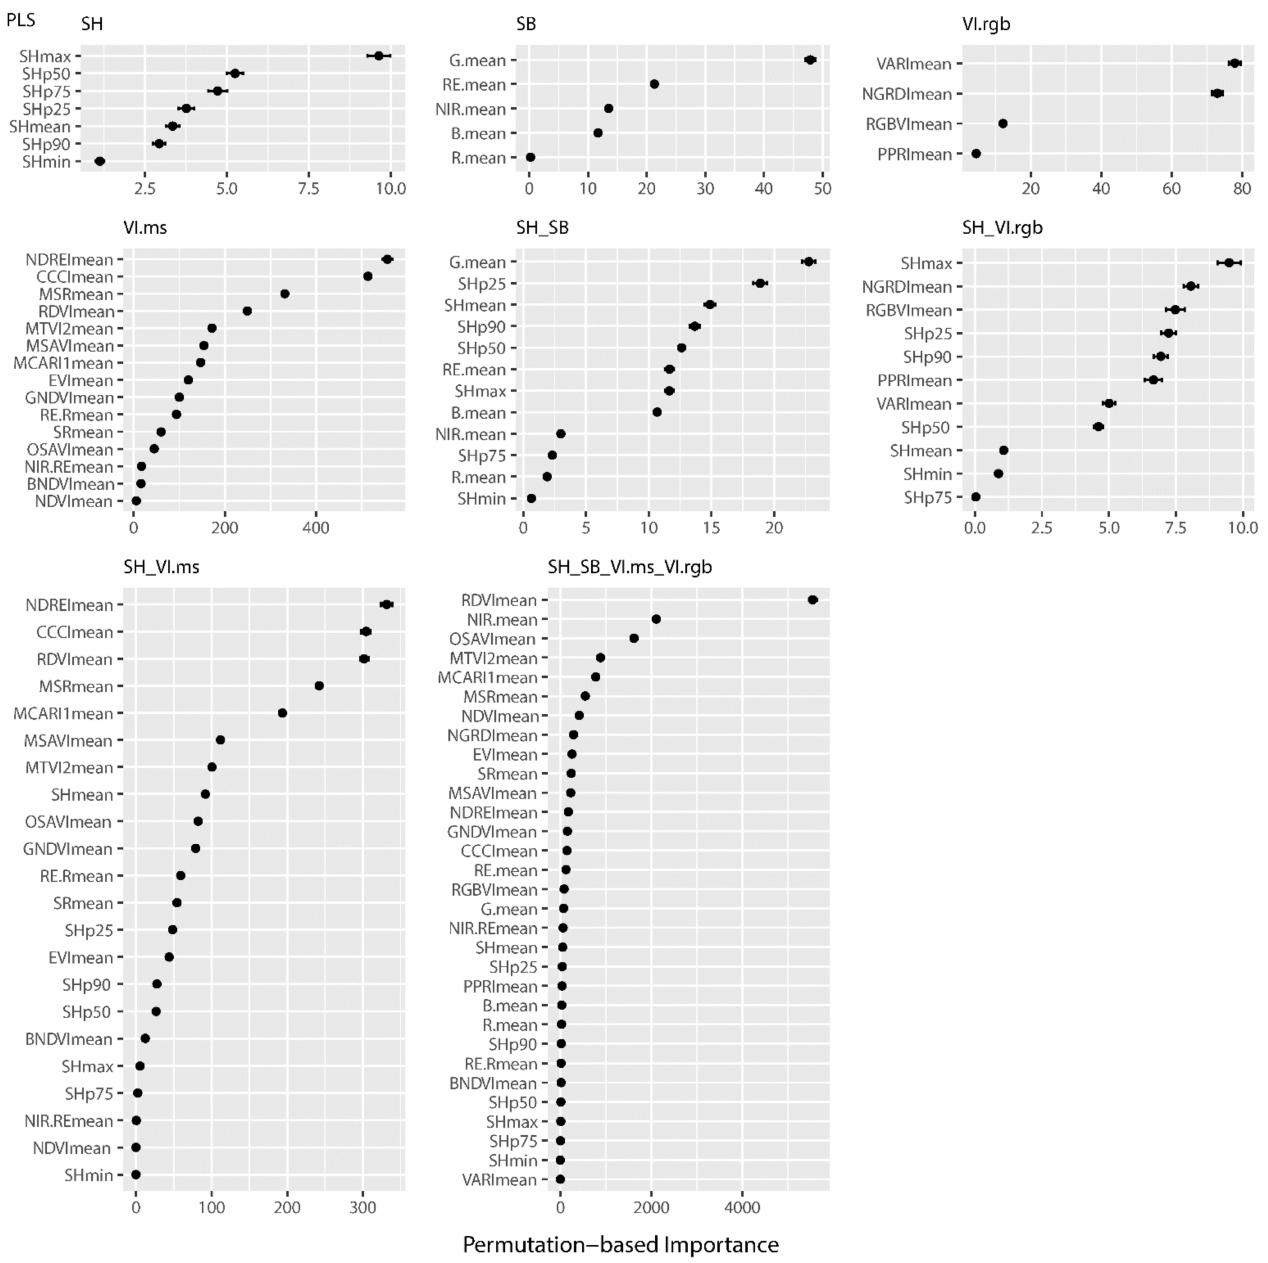
Figure A7. VIP of Nup estimation with